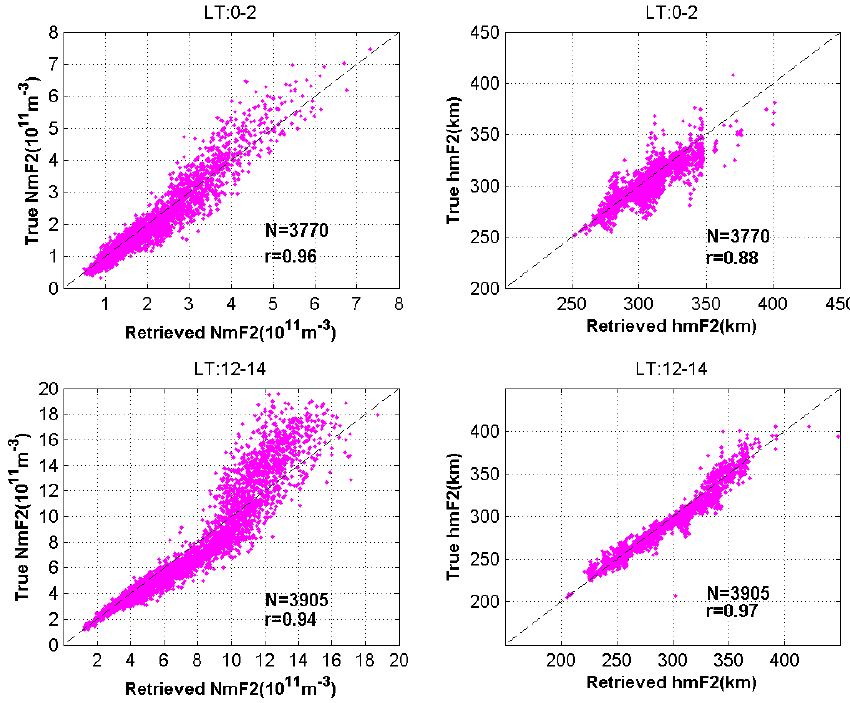
Fig. 1. Correlation between the true and retrieved Nm F2 (left panels) and hm F2 (right panels) during nighttime (00:00–02:00LT, upper panels) and daytime (12:00–14:00LT, bottom panels). The sample numbers and correlation coefficients are given in the